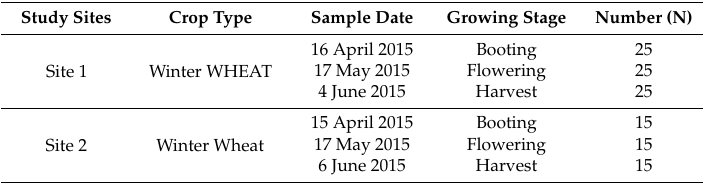
Table 1. The observations of winter wheat in the 2014–2015 agricultural year.